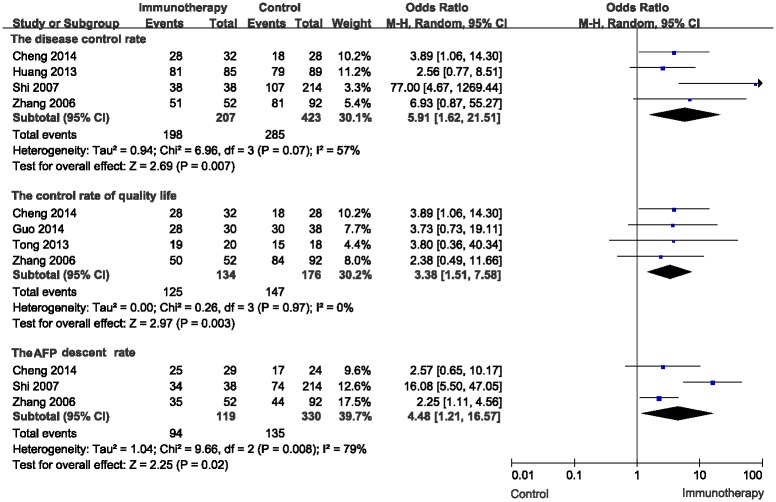
Comparison of short-term efficacy between the patients undergoing cellular immunotherapy or not by using the random effects model (Mantel-Haenszel method).